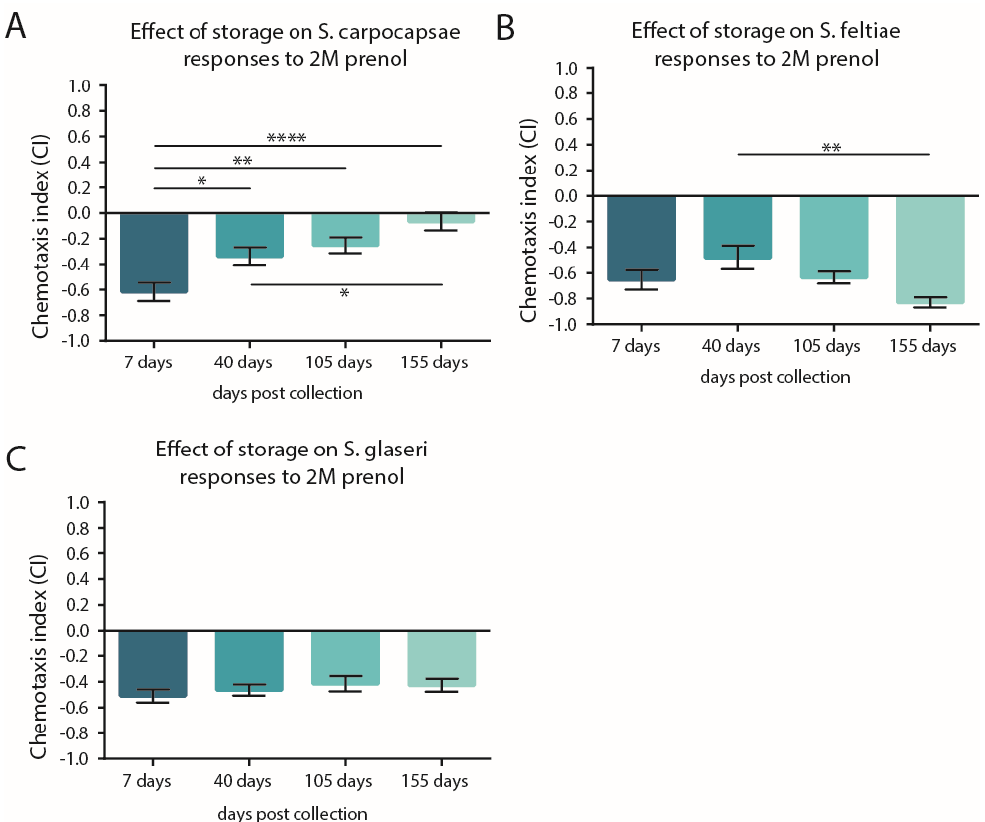
Figure 3. Effects of the storage-time on the responses of the Steinernema infective juveniles (IJs) to 2 M prenol. For the chemotaxis index (CI) values, a score near − 1 indicates a high aversion, near 0 indicates neutrality, and +1 indicates a strong attraction. Three species of Steinernema were selected and the IJs were stored at 15 °C for the specified durations (7 days, 40 days, 105 days, and 155 days) prior to assessing their response to prenol using the PF127 assay medium. The assays were run for 2 h for S. glaseri before being scored, 1 h for S. feltiae , and 6 h for S. carpocapsae . Movement into the test and control regions of the assay were used to calculate the CI. ( A ) The responses of ( A ) S. carpocapsae IJs, ( B ) S. feltiae IJs , and ( C ) S. glaseri IJs. Bars represented the mean with error bars, representing the SEM.